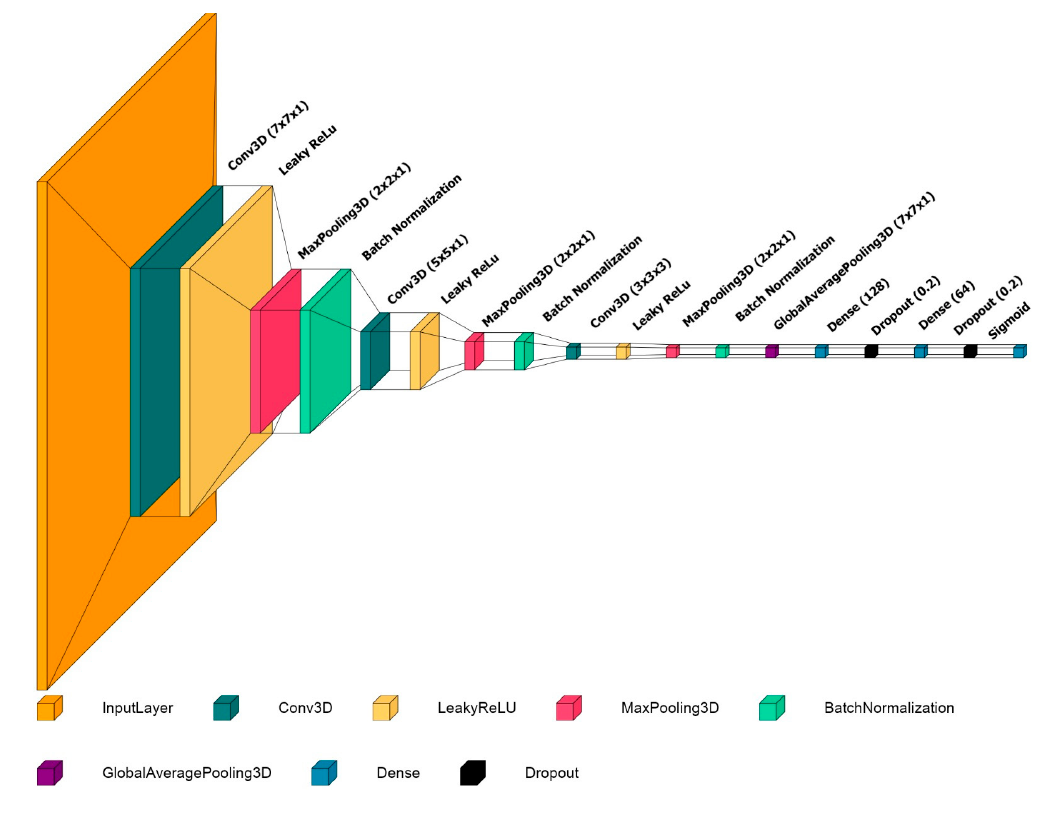
Figure 1. The network structure.